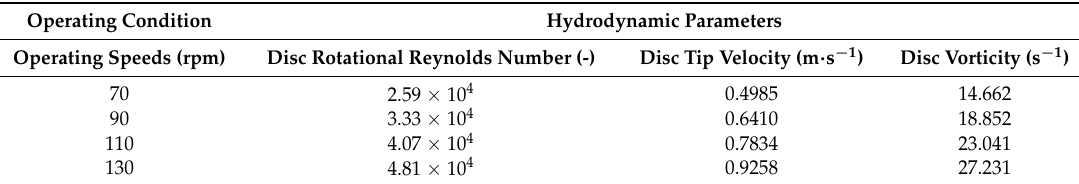
Table 1. Theoretical values of the flow quantities at different operating speeds near the rotating disc boundary layer.